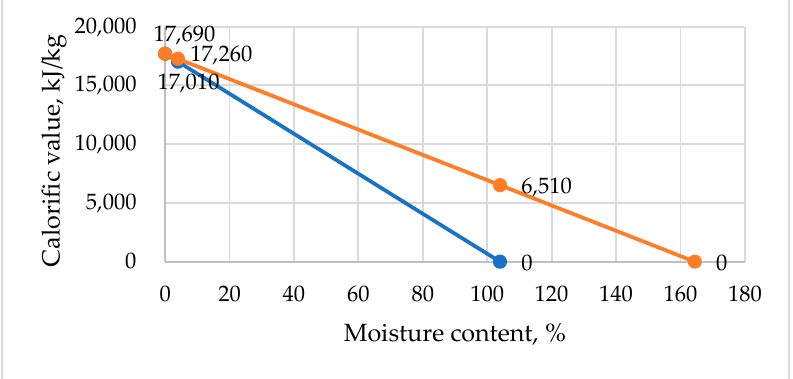
Figure 5. The influence of moisture content on the calorific value for straw briquettes: red line-HCV, blue